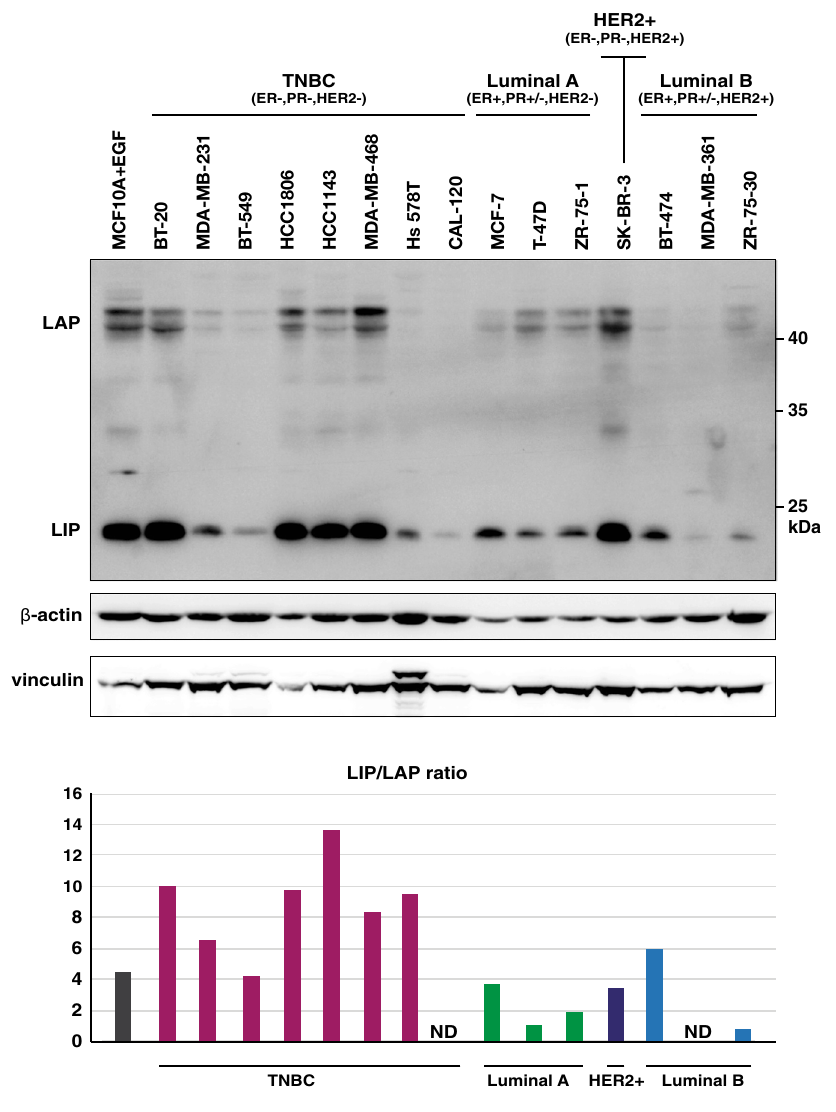
Fig. 1 High LIP/LAP expression ratios in TNBC cells. The immunoblot shows the expression of LIP and LAP in a panel of TNBC (ER − , PR − , HER2 − ), luminal A (ER + , PR + / − , HER2 − ), HER2-positive ( + ) (ER − , PR − , HER2 + ), luminal B (ER + , PR + / − , HER2 + ) type breast cancer cell lines 25 and in untransformed MCF10A supplemented with EGF required for proliferation and known to induced LIP. The blots below show β -actin as a low-molecular and vinculin as a high-molecular loading control. The bar graph shows the relative LIP/LAP isoform ratio quanti fi cation per cell line of the blot shown. The LAP signals of CAL-120 and MDA-MB-361 were too low for reliable quanti fi